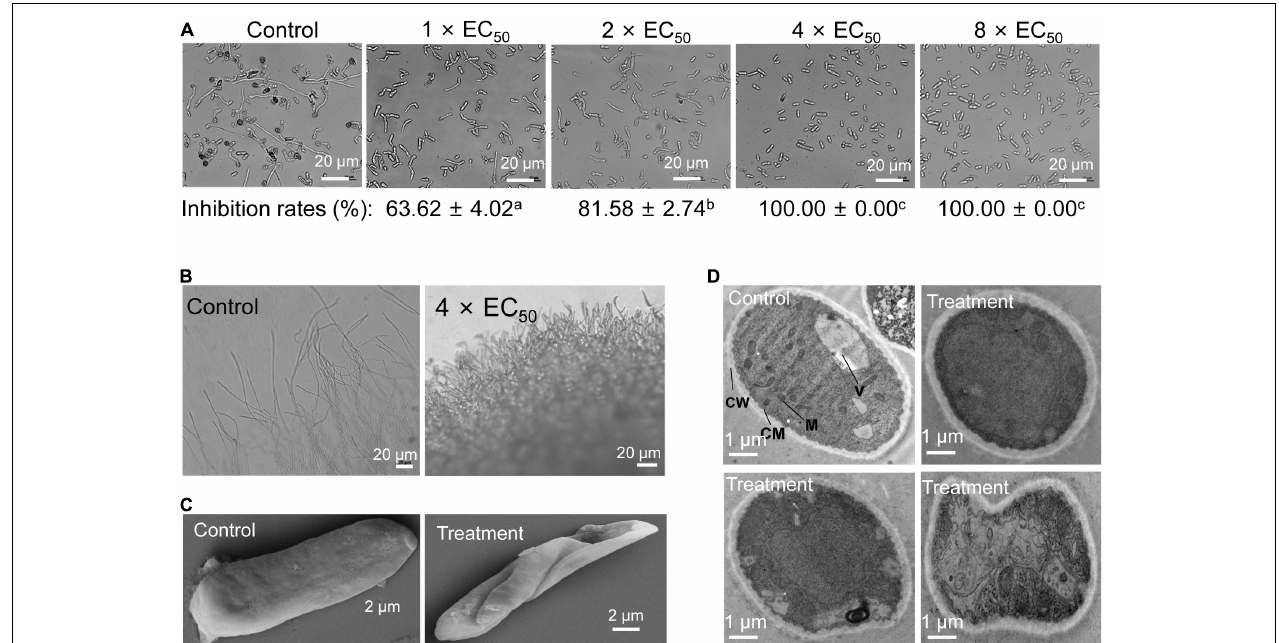
FIGURE 5 | Inhibitory effects of strain QN1NO-4 extract on conidial germination, mycelial morphology, and ultrastructure of C. fragariae. (A) Conidial germination assay of C. fragariae after treatment with 1 × , 2 × , 4 × , or 8 × EC 50 extracts. Bar = 20 µ m. CW: cell wall; CM: cell membrane; M: mitochondria; V: vacuole. (B) Growth characteristics of C. fragariae mycelia treated with 4 × EC 50 of extract. Bar = 20 µ m. (C) Representative pictures showing the mycelial morphology of C. fragariae after treatment with 4 × EC 50 of extracts. Bar = 20 µ m. (D) Representative pictures showing the ultrastructure of C. fragariae after treatment with 4 × EC 50 of extract. Bar = 1 µ m.